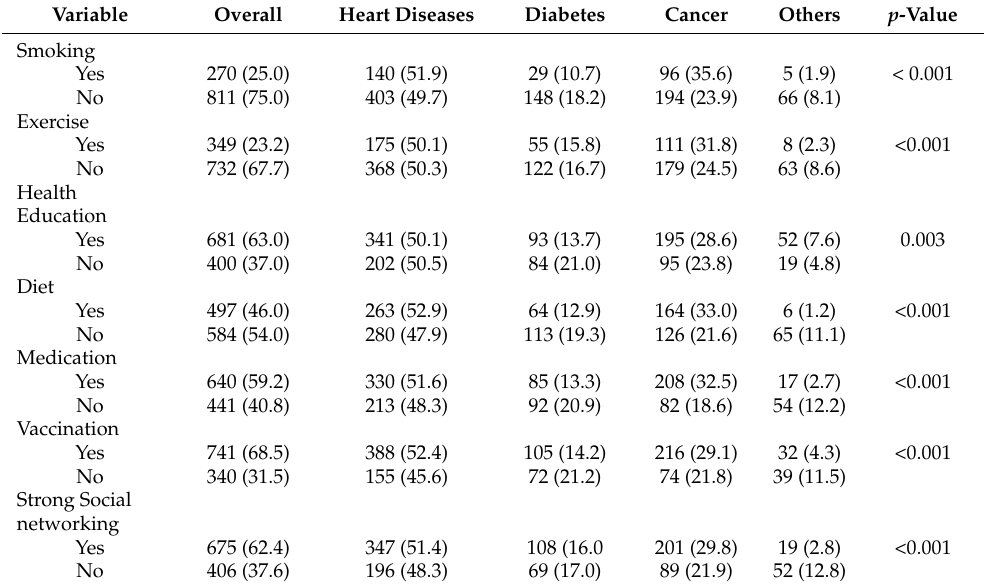
Table 3. Behavioral characteristics of caregivers.